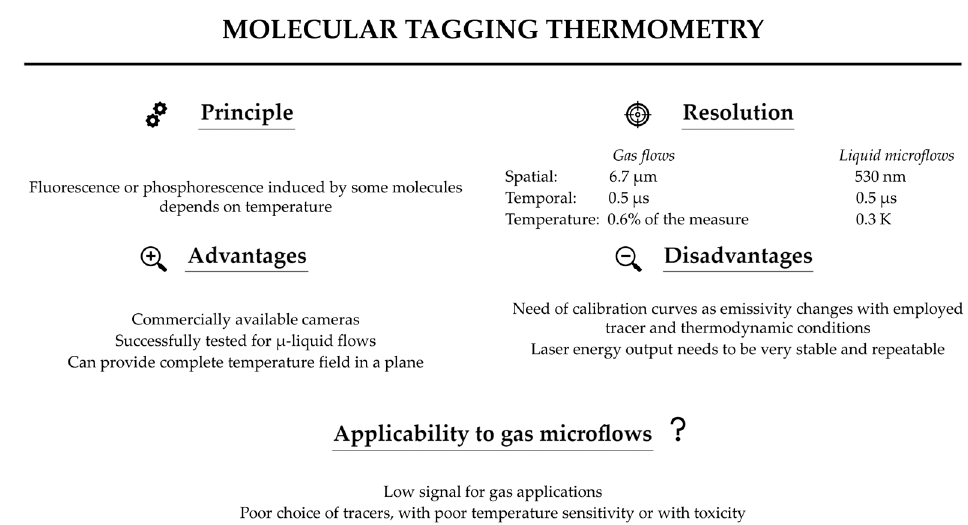
Figure 43. Summary of molecular tagging thermometry features. For gas flows, values of spatial and temporal resolutions are from [185], and value of temperature resolution is from [187]. For liquid flows, values of spatial and temporal resolutions are from [196], and value of temperature resolution is from [198].